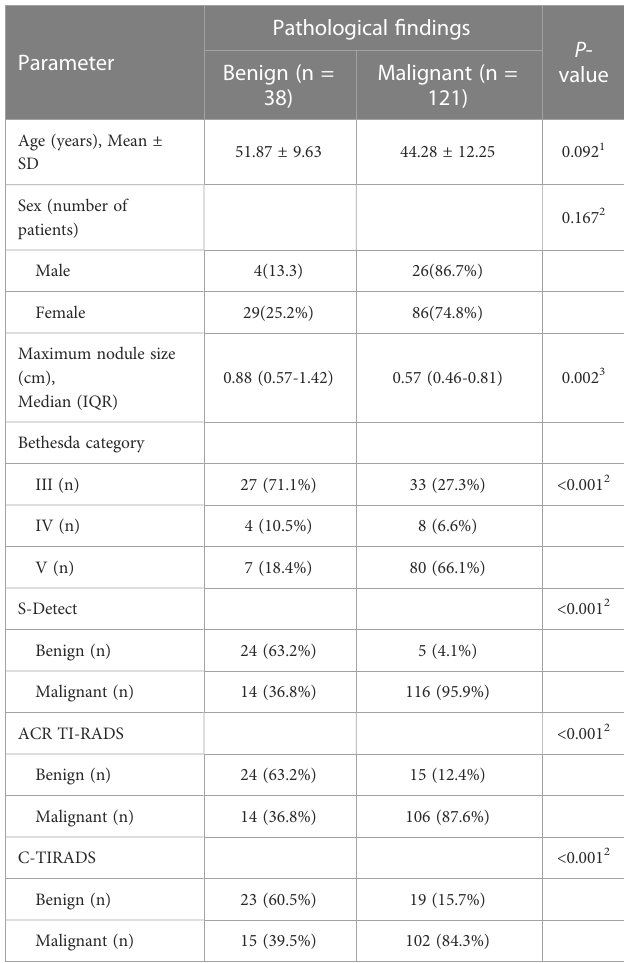
TABLE 5 Malignancy risk of the cytologically indeterminate thyroid nodules in different categories.